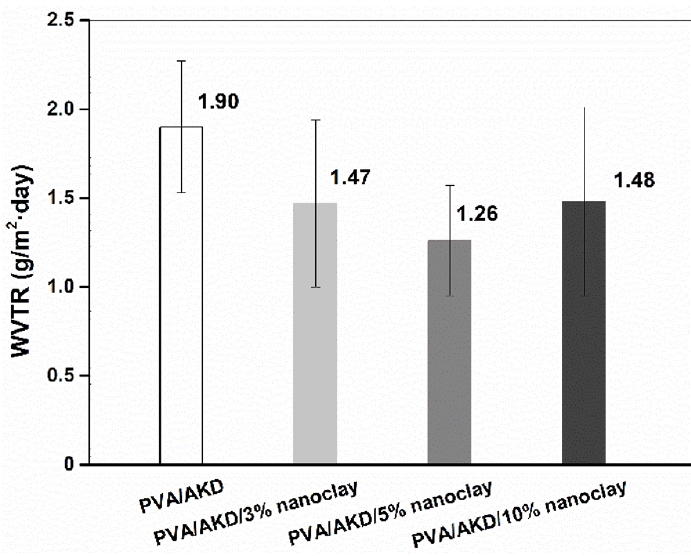
Figure 8. WVTR of the base paper and coated